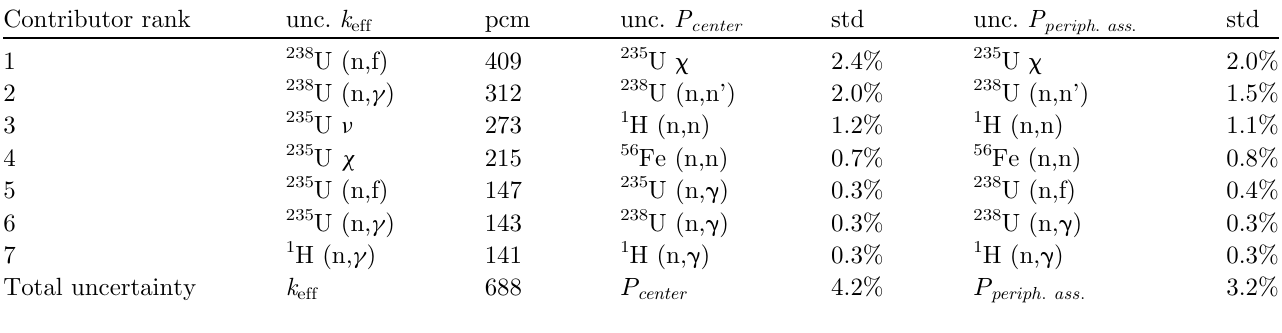
Table 2. Main contributors and total propagated uncertainty (1 s ) with COMAC-V0.